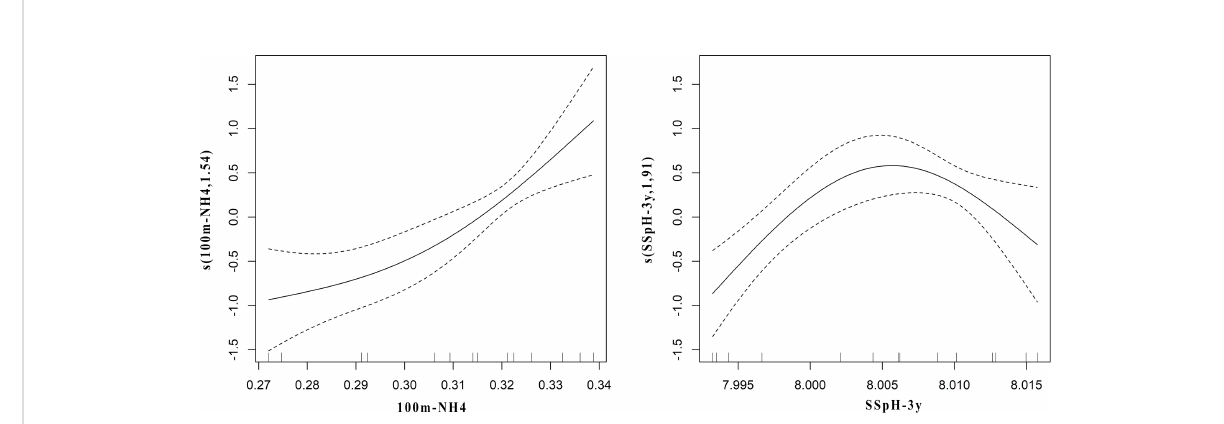
FIGURE 6 Partial GAM plots for the GAM model for P. regalis population in the Strait of Sicily. Each plot represents the estimated smoothing curves (solid line) obtained for 100m-NH 4 (left panel) and SSph-3y (right panel). The environmental variables are represented on the x -axis, and the y -axis shows the contribution of the smoother to the fi tted values. Untransformed values are provided on the x -axis for easier interpretation. Dotted lines indicate the 95% con fi dence